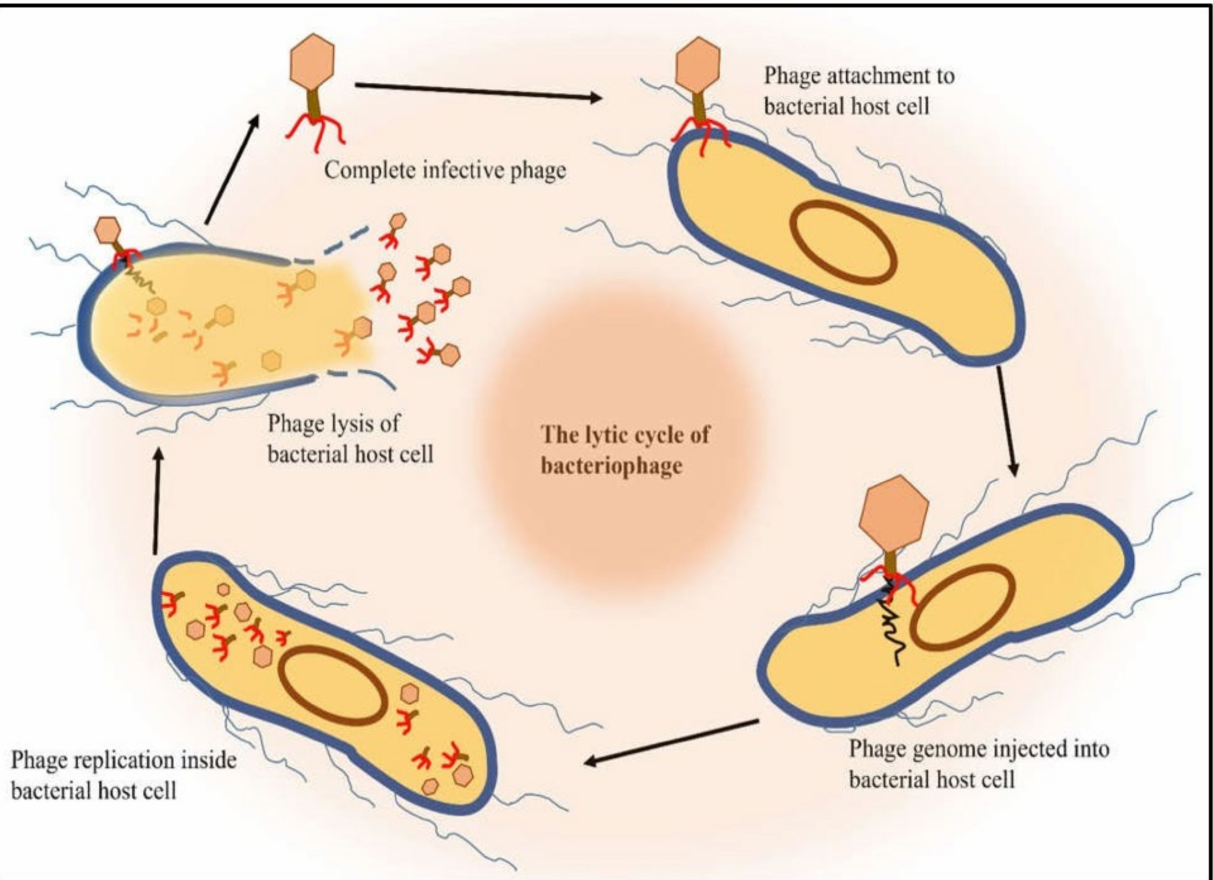
Figure 1. Lytic cycle of bacteriophages. The lytic cycle is one of the two cycles of bacteriophage replication that leads to the lysis and destruction of the infected cell. These bacteriophages that employ the lytic cycle have been shown to have significant importance in biocontrol of bacteria in livestock infections, where they target bacteria with high host-specificity. In the lytic cycle, the bacteriophage genome does not integrate with the host bacterial cell genome, instead, the DNA is found in the cytoplasm of the host cell as separate and free-floating molecule, replicating separately from the host bacterial